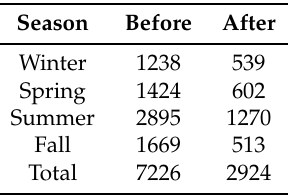
Table 2. Number of aerosol light absorption coefficients measurements before and after the application of the screening scheme, split up by